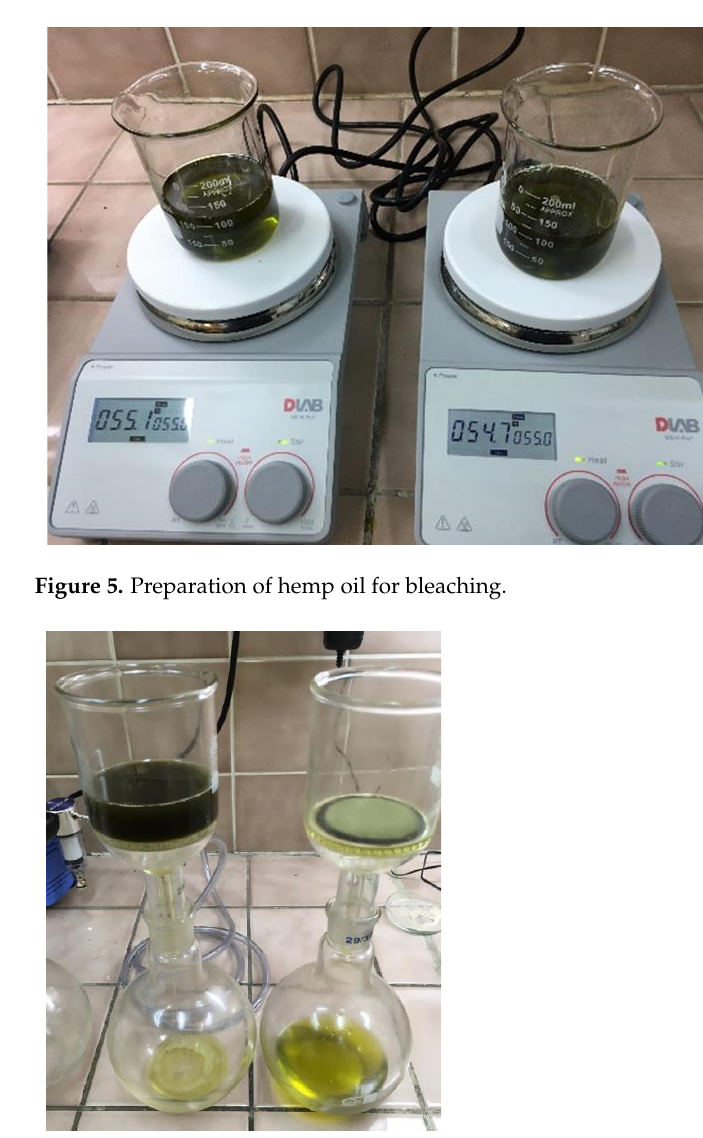
Figure 6. Separation of bleaching earth from oil. The fatty acid methyl esters (FAMEs) were quantified by a gas chromatography method using a J & W Scientific HP- 88 series 100 m × 0.25 mm × 0.20 μm fused silica capillary column (Agilent Tech. Inc., St. Clara, CA, USA) and flame-ionization detector (FID) from Agilent Tech. Hemp oils were saponified with 0.5 M KOH in methanol. Trans- esterification of fatty acids with the BF 3 (boron trifluoride) solution in methanol was car- ried out using the official American Oil Chemists ’ Society (AOCS) Ce 2 – 66 method [54]. We used a 7890 A series gas chromatograph (Agilent Tech. Inc., St. Clara, CA, USA) at an injection volume of 1.0 mL and a split ratio of 1/50. Helium was used as the carrier gas at a head pressure of 2.0 mL/min at a constant flow. Air, hydrogen, and helium make-up gas flow rates by FID (Agilent Tech. Inc., St. Clara, CA, USA) were 450, 40, and 30 mL/min, respectively. The detector and injector temperatures were chosen as 280 °C and 250 °C, respectively. The initial column temperature of 120 °C was held for 1 min, increased to 175 °C at 10 °C/min and then held for 10 min. It was then increased to 210 °C at 5 °C/min, held for 5 min, increased to 230 °C at a rate of 5 °C/min, and maintained for 5 min. The